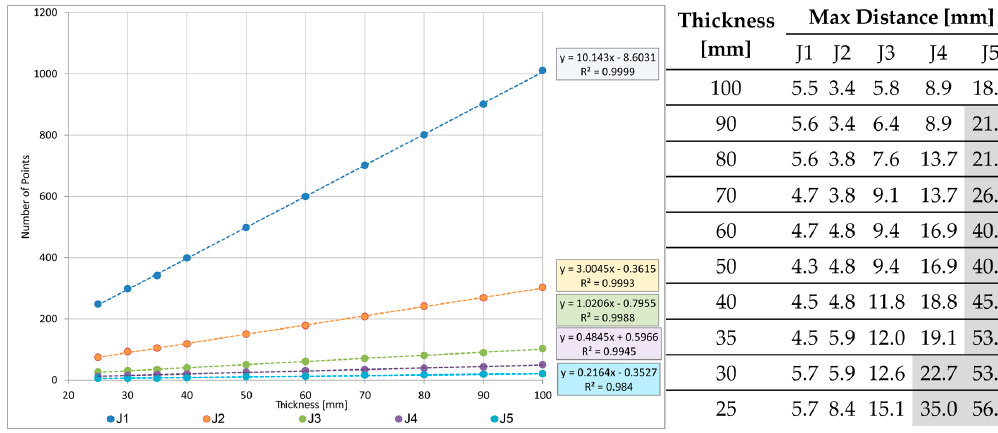
Figure 10. Relationship between the points contained in a 150 mm long rectangular area over the joints and the thickness of the area. Left panel: point density. Right panel: maximum distance between couple of points. Values exceeding 20 mm are highlighted in grey.